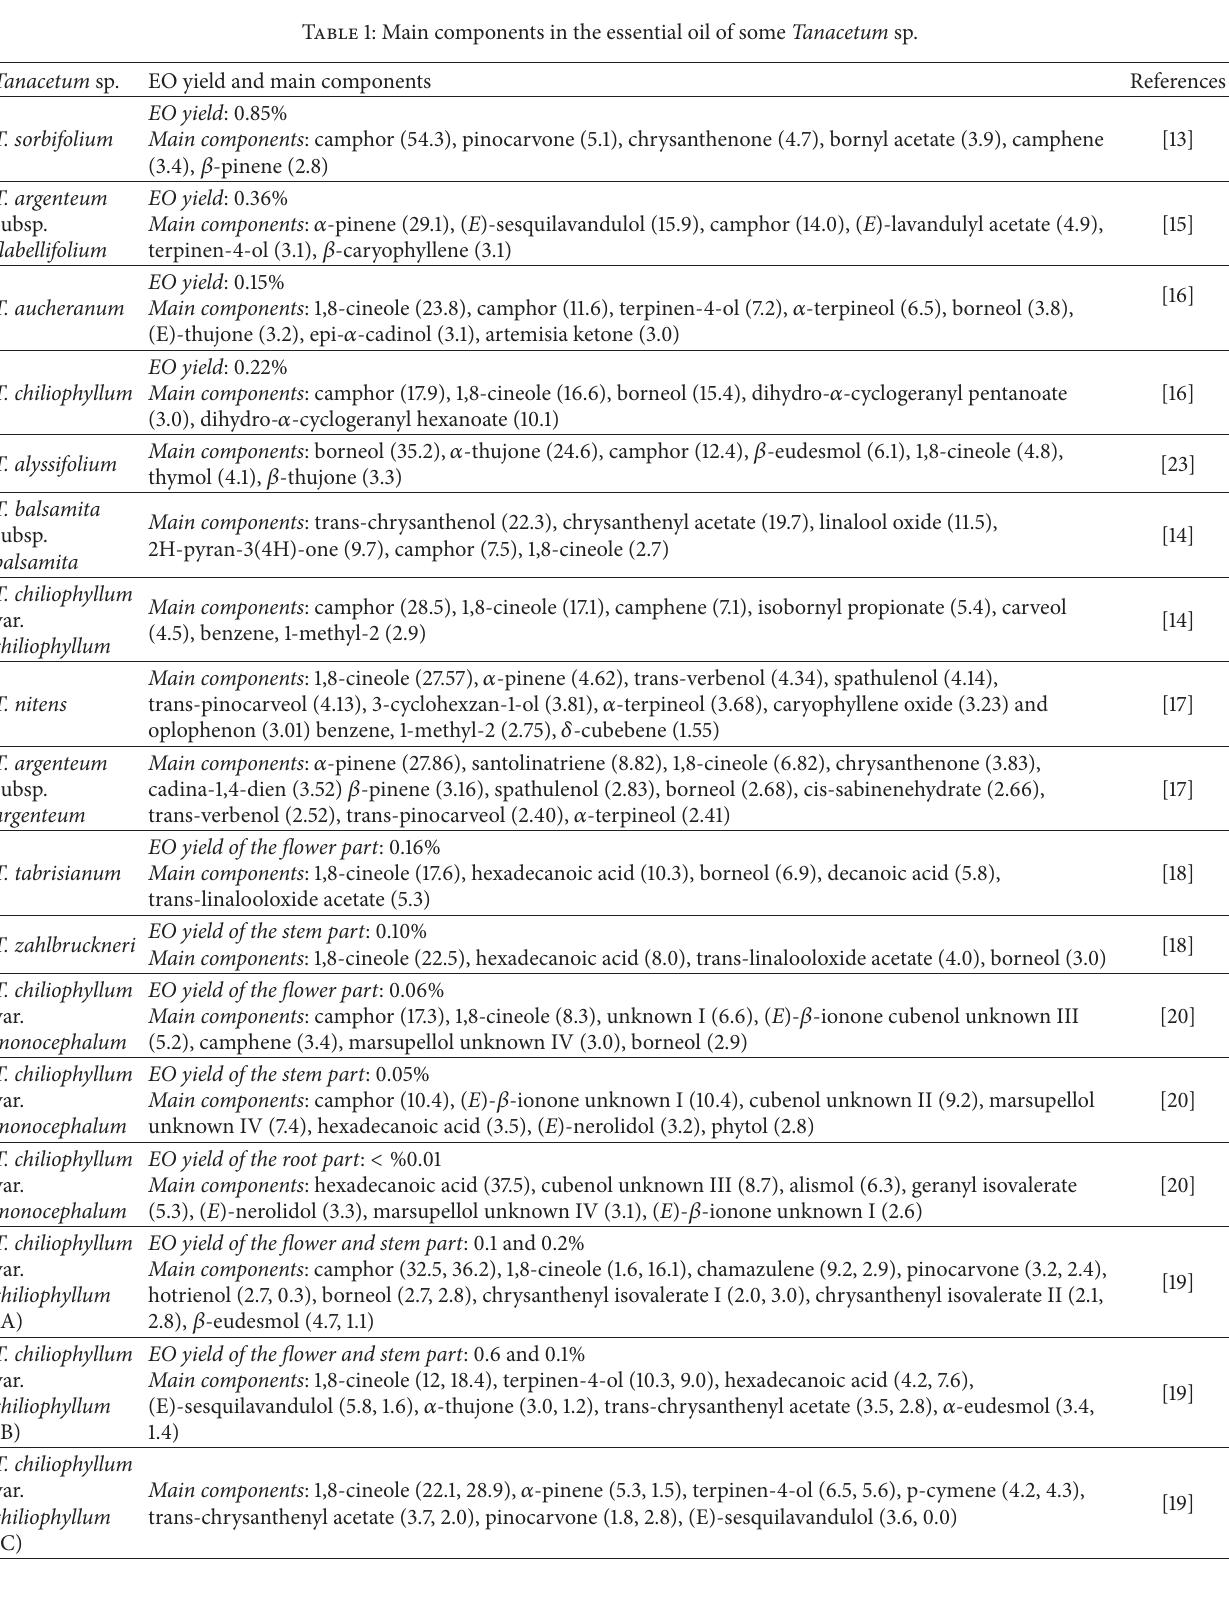
Table 1: Main components in the essential oil of some Tanacetum sp. Tanacetum